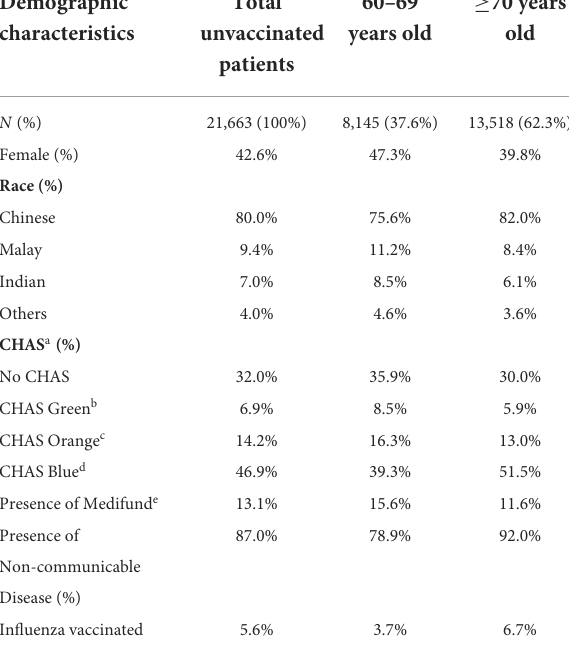
TABLE 1 Sociodemographic characteristics of the unvaccinated adults by age groups. Demographic